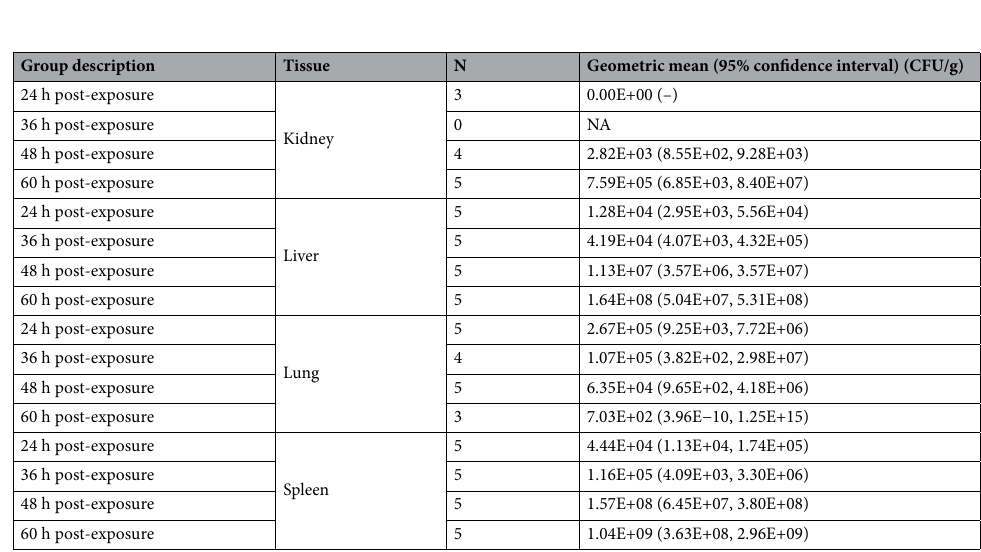
Table 4. Geometric means with 95% confidence intervals for tissue bacterial load in untreated animals. The geometric means in CFU/g for kidney, liver, lung, and spleen bacterial burdens of infected, untreated animals at 24, 36, 48, and 60 h post-exposure. Mean bacterial burdens in the liver and spleen increased at 60 h post-exposure compared to 24 h post-exposure, while mean bacterial loads in the lung decreased. – All measurements were the same (negative), therefore the 95% confidence interval could not be calculated. NA No quantitative data were available.